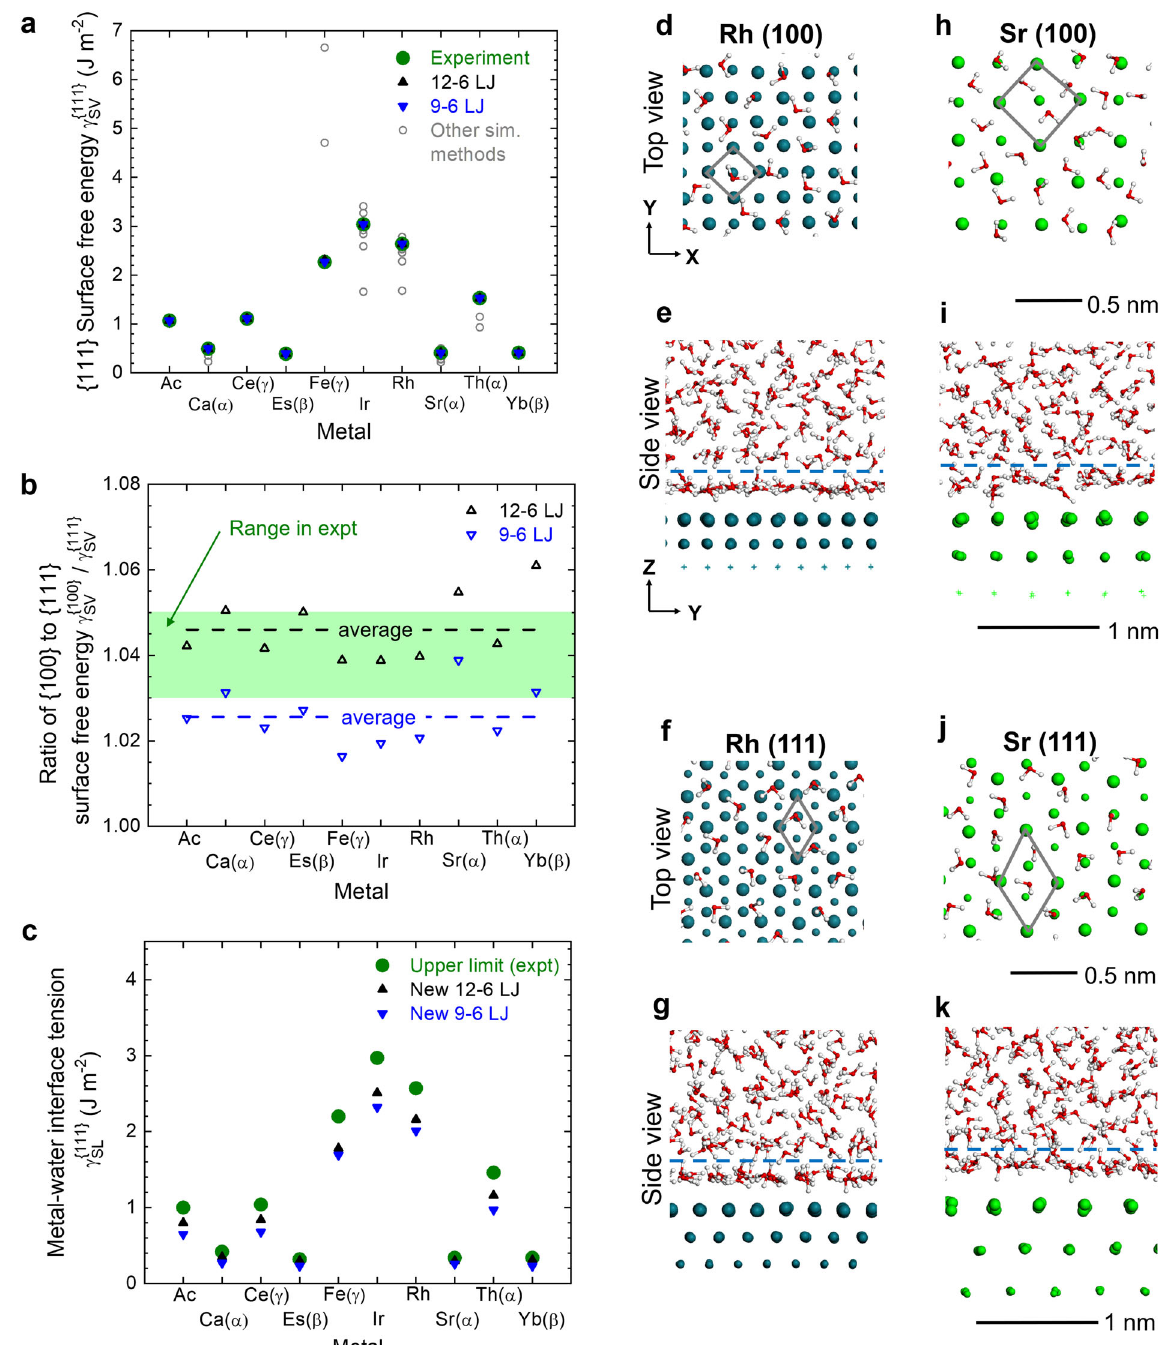
Fig. 2 Surface and interfacial properties of the fcc metals. a The (111) surface free energy in experiments, in the simulation with the LJ models, and according to other computational models such as DFT, tight binding, and EAM. The LJ models achieve the best match. b Ratio of the (100) surface free energy to the (111) surface free energy using the LJ models. Experiments suggest values between 1.03 and 1.05 consistent with the calculations using the LJ parameters (refs. 73 – 75 ). c The (111) metal – water interface tensions computed with the 12-6 LJ models (CVFF, CHARMM) and 9-6 LJ models (PCFF). Flexible SPC and SPC-like water models were used. The upper limit of the metal – water interface tension according to experimental data and the Young equation is also shown, showing agreement with the computed data. d , e Example of a Rh (100) – water interface in equilibrium. About 1 water molecule in the fi rst molecular layer is available per 1 Rh atom in the top atomic layer, and the fi rst molecular layer of water on the surface is strongly bound. f , g Similar trends are seen on an Rh (111) – water interface in a different geometry. Water molecules are frequently found near epitaxial sites (fcc and hcp) and less often near top sites on both (111) and (100) surfaces. h , i A Sr (100) – water interface before the reaction to Sr(OH) 2 and H 2 . Due to a larger lattice constant of Sr compared